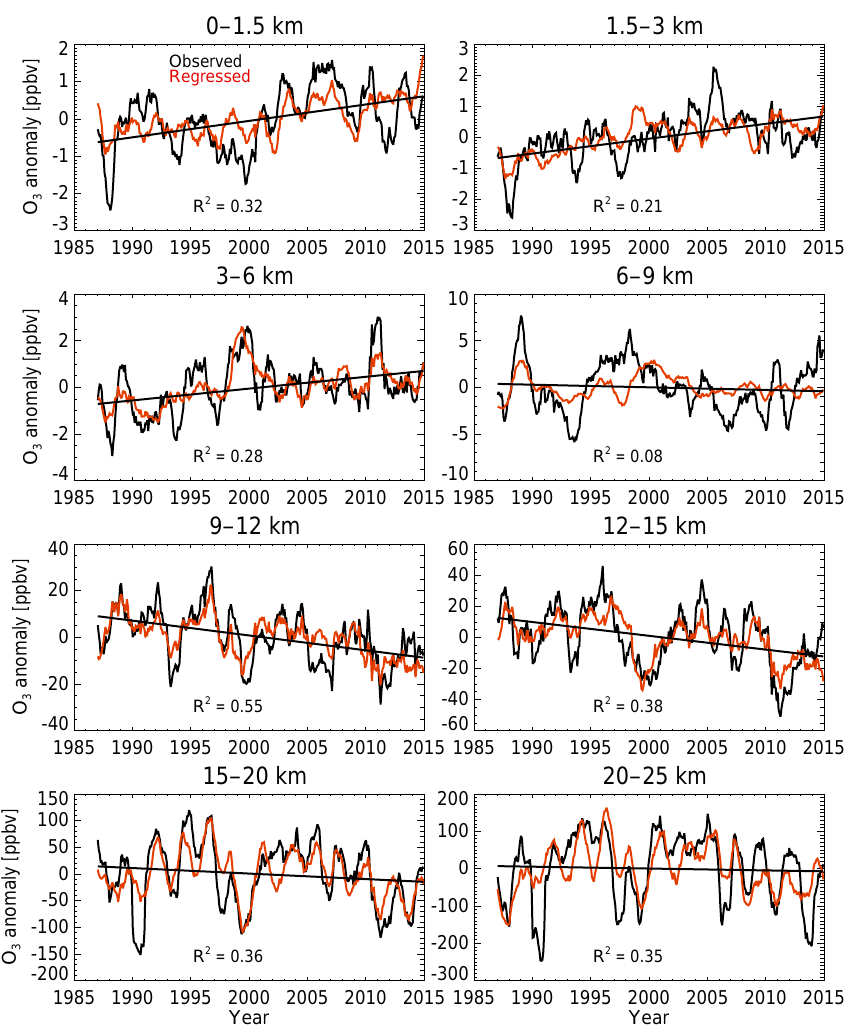
Figure 2. Vertically resolved observed ozone anomalies (black curves), linear trends (black lines), and regressed O 3 anomalies (red curves) at Lauder (1987–2014). R 2 is the coefficient of determination of multi-variant regression function at each layer. The O 3 anomalies shown are smoothed using a 13-month filter based on monthly mean data. Linear trends are calculated from the monthly mean O 3 anomalies.